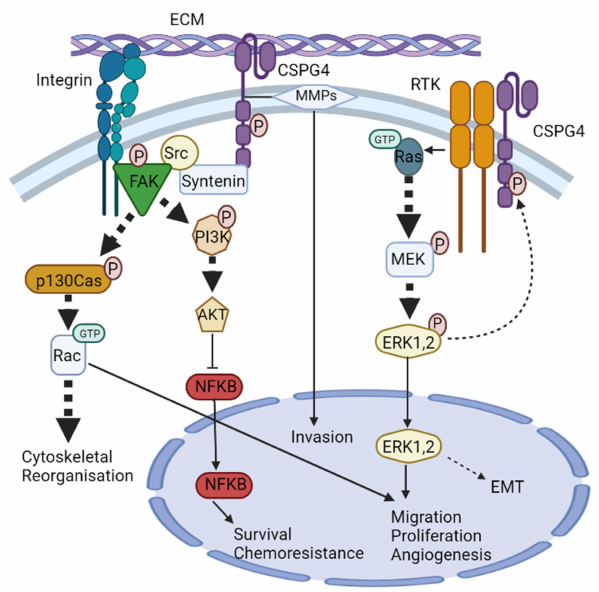
Figure 2. CSPG4 signalling pathways. CSPG4 activates two major signalling cascades via its